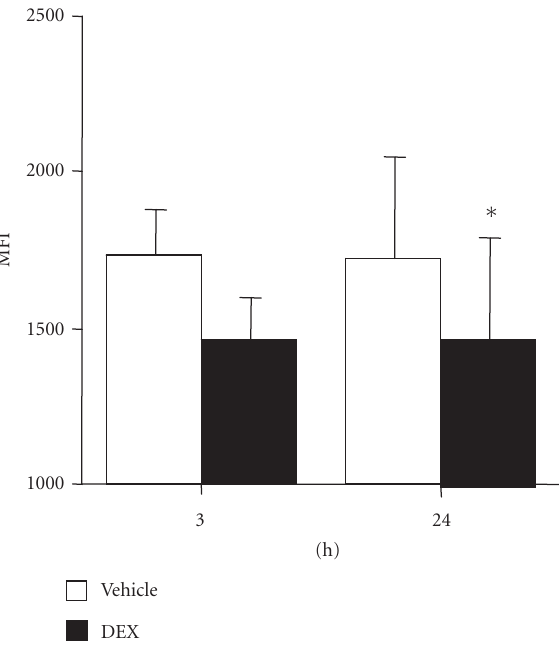
Figure 2: DEX e ff ects on RA synovial fibroblast intracellular an- nexin I. Annexin I protein was detected in cultured RA FLS by per- meabilization flow cytometry and displayed as mean ± SEM mean fluorescence intensity (MFI). Compared to control (open bars), cells treated with DEX 10 − 7 M (filled bars) exhibited reduced in- tracellular annexin I at 3 hours and 24 hours, respectively ( n = 6). ∗ P < . 05. Figure 3: DEX e ff ects on RA synovial fibroblast cell surface annexin I. RA FLS were exposed to DEX 10 − 7 M for 3 hours and 24 hours, respectively. Cell surface annexin I was detected by Western blot- ting. Lanes 1 and 2 show 3-hour control, and DEX-treated cell sur- face eluates, lanes 3 and 4 show 24-hour control, and DEX-treated cell surface eluates. A 37 kD band representing full-length annexin I was increased at 3 hours and increased further at 24 hours in